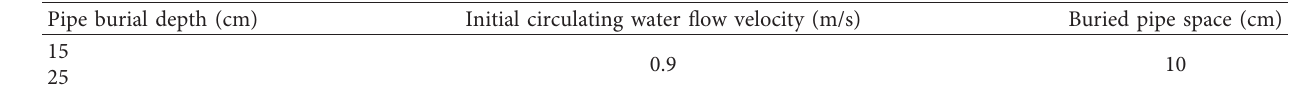
Table 3: Design of buried depth working conditions.